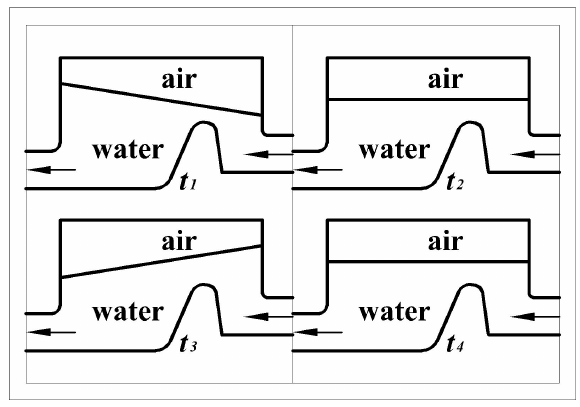
Figure 1. Sloshing in the water-retaining tank.